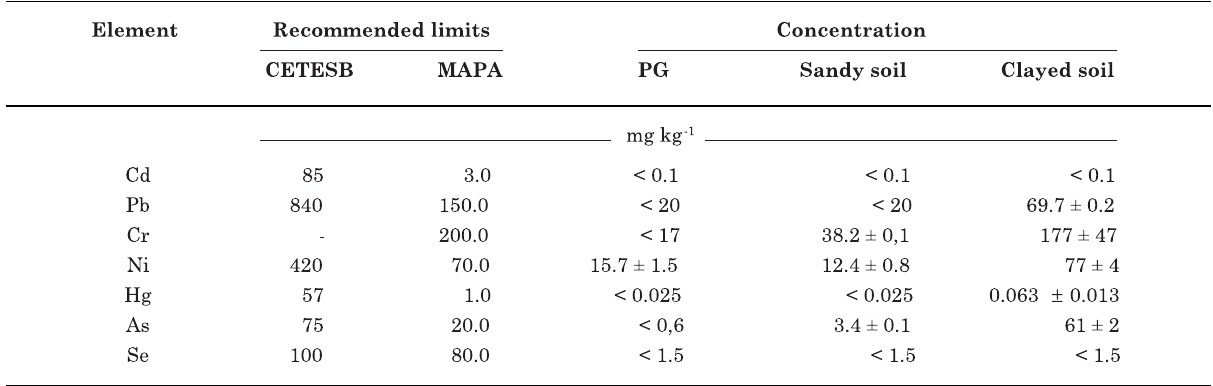
Table 4. Metal and metalloid concentration